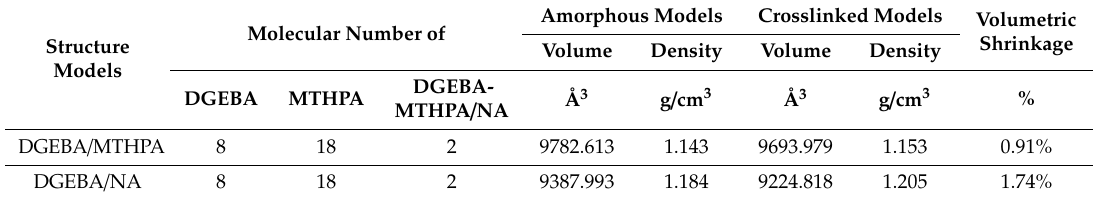
Table 1. Initial parameters of DGEBA / MTHPA and DGEBA / NA epoxy resin models.